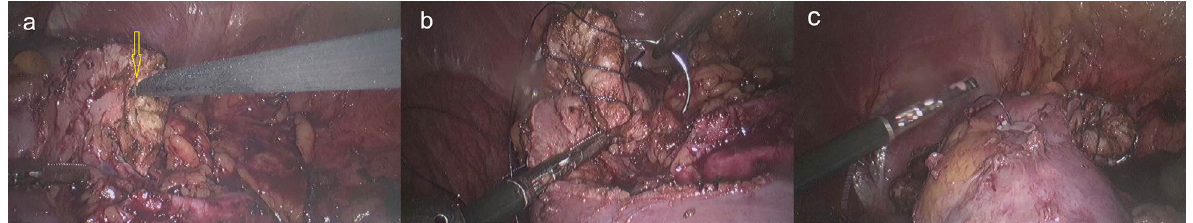
Fig. 5 a Surface coagulation by electrosurgical spatula (marked with yellow arrow). b and c Renorrhaphy by sliding clip technique